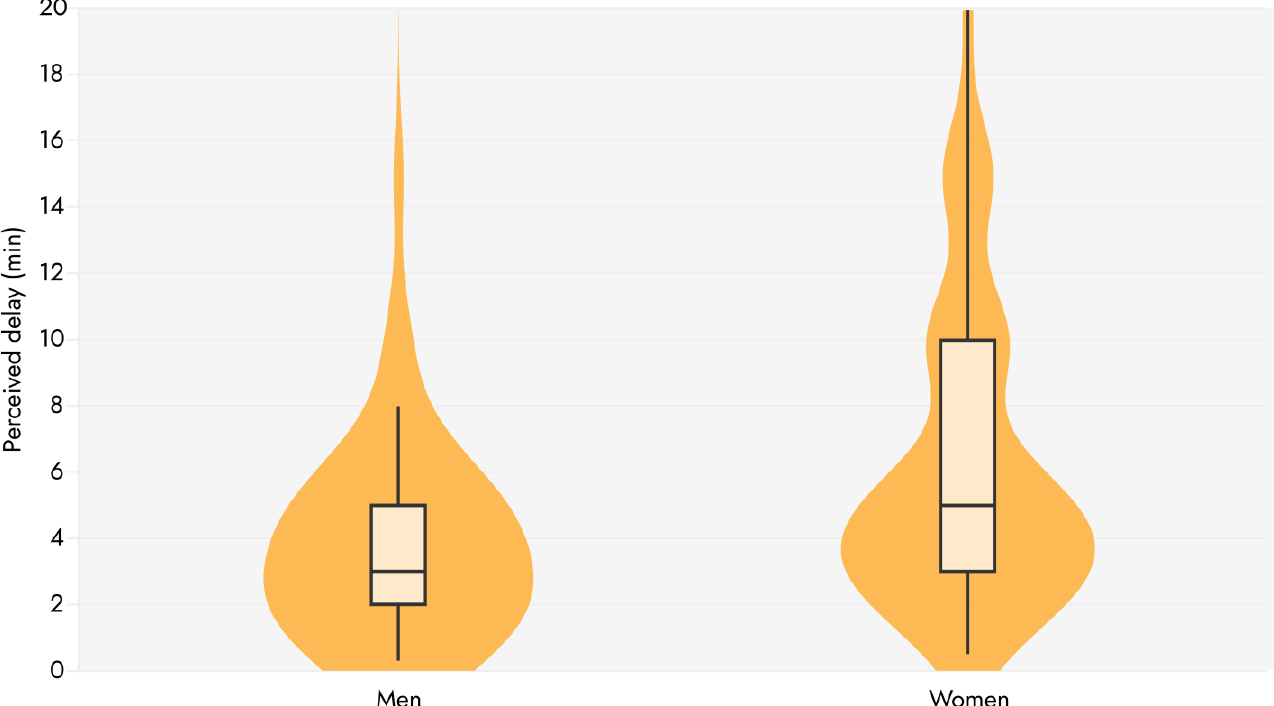
Figure 10. Violin plots of the delay perceived by men and women.